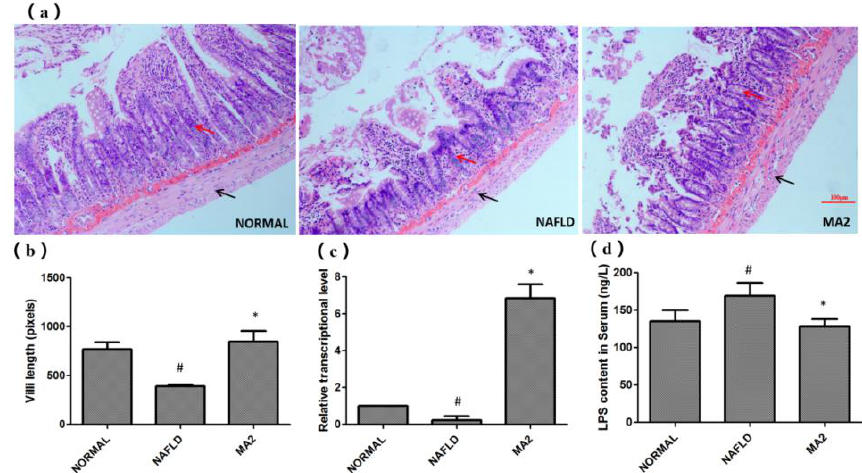
Figure 3. The protective effect of L. plantarum MA2 on the intestinal barrier of rats. ( a ) The tissue morphology of the ileum in different groups (H&E staining, scale bars: 50 mm), the villi and the muscula are marked by red and black arrows, respectively, ( b ) the villi length, in pixels, n = 10, ( c ) expression of intestinal tight junction protein claudin-1, ( d ) serum LPS levels in different groups of rats, (# indicates p < 0.05 compared with the normal group; * indicates p < 0.05 compared with the NAFLD group. NORMAL: normal group, NAFLD: non-alcoholic fatty liver disease, MA2: L. plantarum MA2 treatment group).